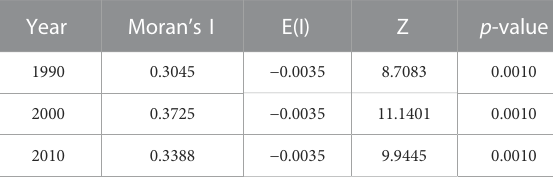
TABLE 2 Global spatial autocorrelation